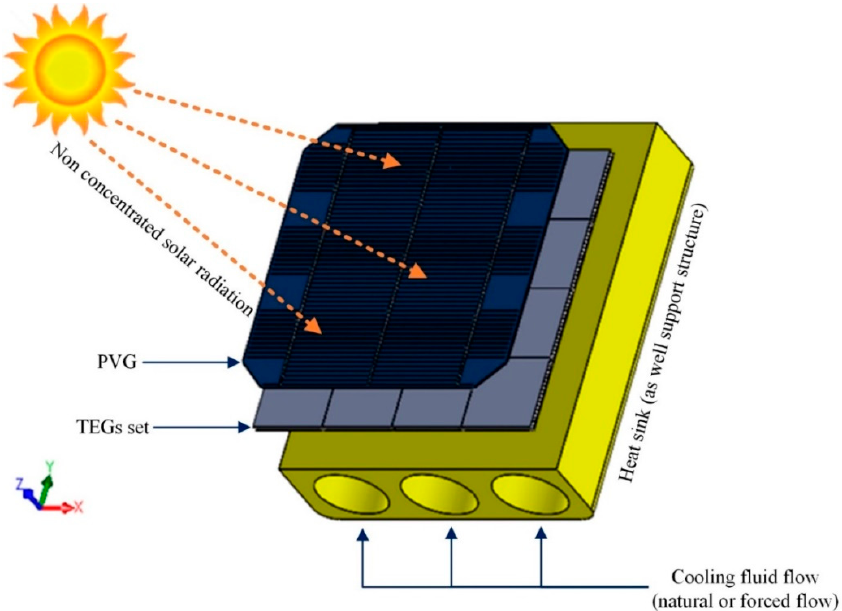
Figure 5. Constructive scheme of the proposed STEG.